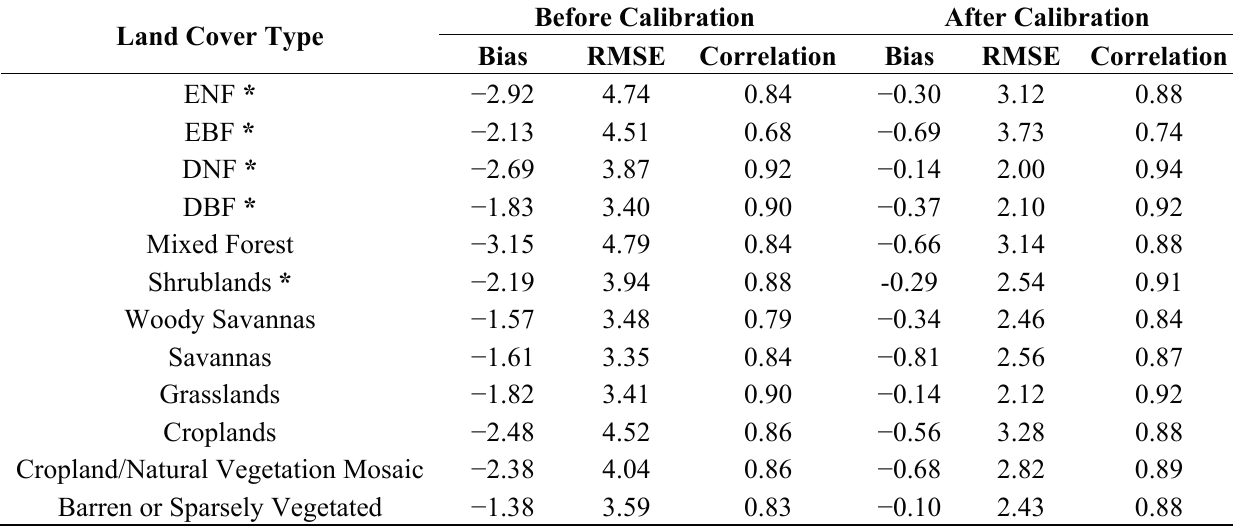
Table 7. Summary of sensor descending (AM) orbit T Mean Square Error (RMSE) differences and Correlation Coefficients estimated from overlapping AMSR and MWRI records before and after T cover type areas within the global